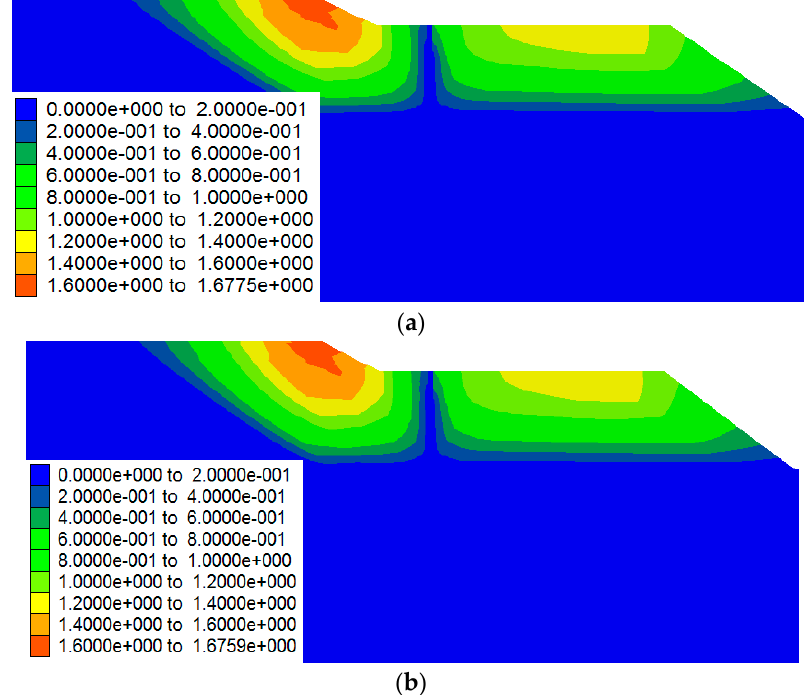
Figure 9. Monitoring surface and displacement nephogram. ( a ) 1. ( b ) 2.